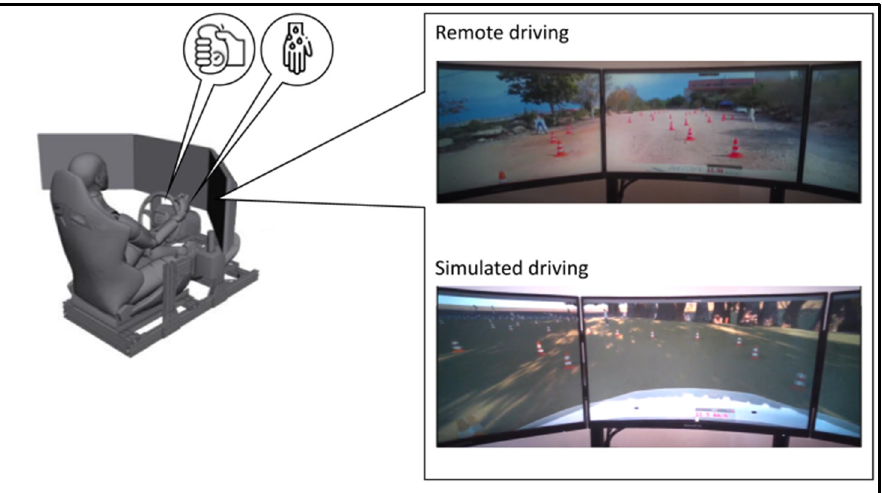
Figure 1. Illustration of the operator station used to operate both the remotely controlled vehicle and the driving simulation (with the same HMI) while grip force on the steering wheel and electrodermal activity are measured.